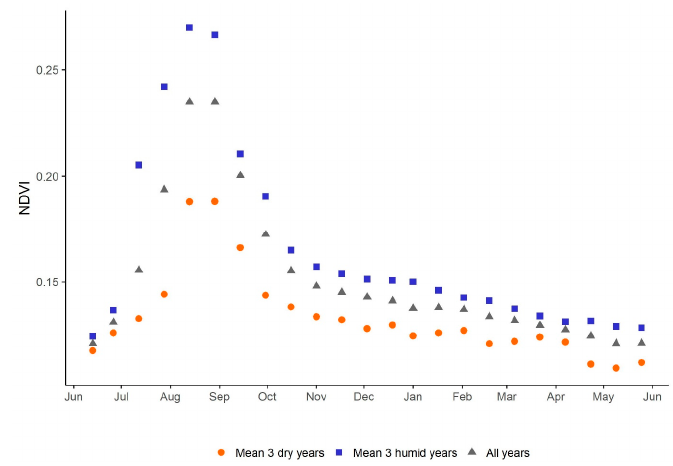
Figure 9. Average NDVI cycle (2000–2016) of the Agoufou watershed from MODIS vegetation indices MOD13Q1 and MYD13Q1 (250 m and 16-days intervals) for normal, wet, and dry years.